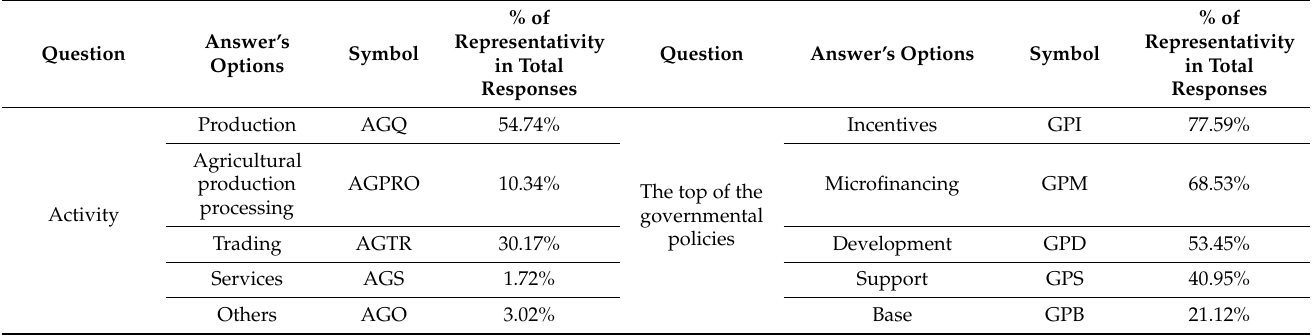
Table 1. The questionnaire